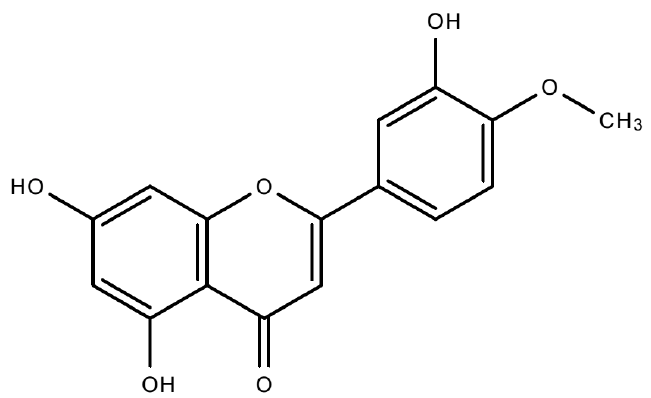
Figure 6. Chemical structure of Diosmetin.